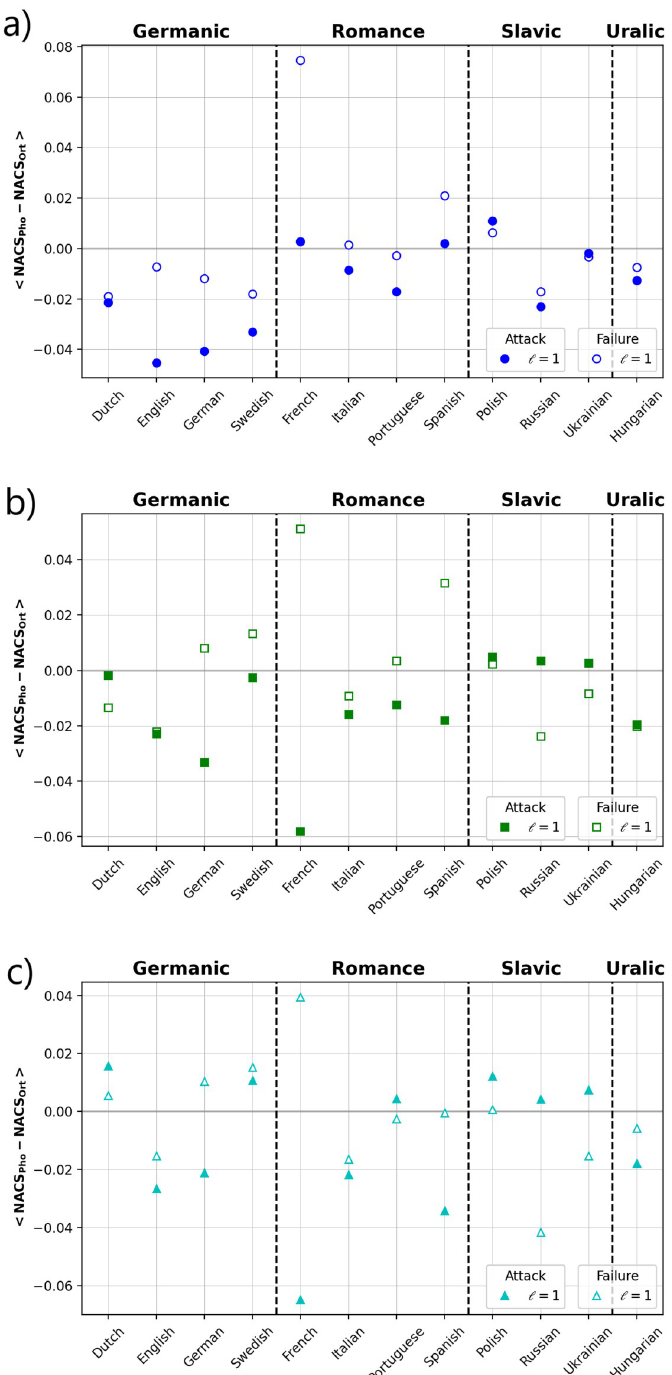
Fig 8. Average component size differences between phonological and orthographic networks. We show the cases of attacks (filled circles) and failures (open circles) for several thresholds ℓ of the DL distances, a) ℓ = 1, b) ℓ = 2, and c) ℓ = 3. The results for failures correspond to the average from 10 independent